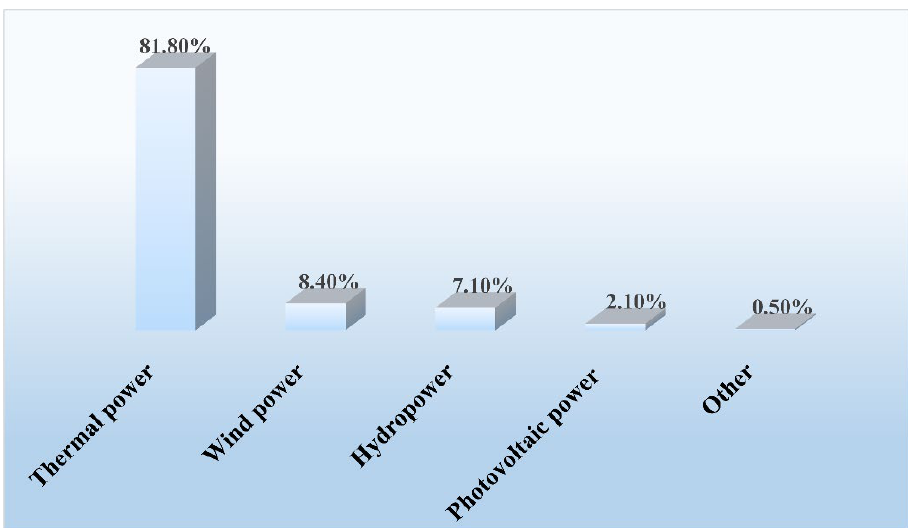
Figure 16. Percentage of U.S. Electricity Generation of four main